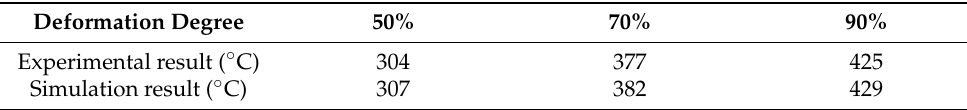
Figure 15. Simulation results of bimetal gears with different degrees of deformation: ( a ) 50%, ( b ) 70%, ( c ) 90%. Table 5. Temperature at the central position of aluminum